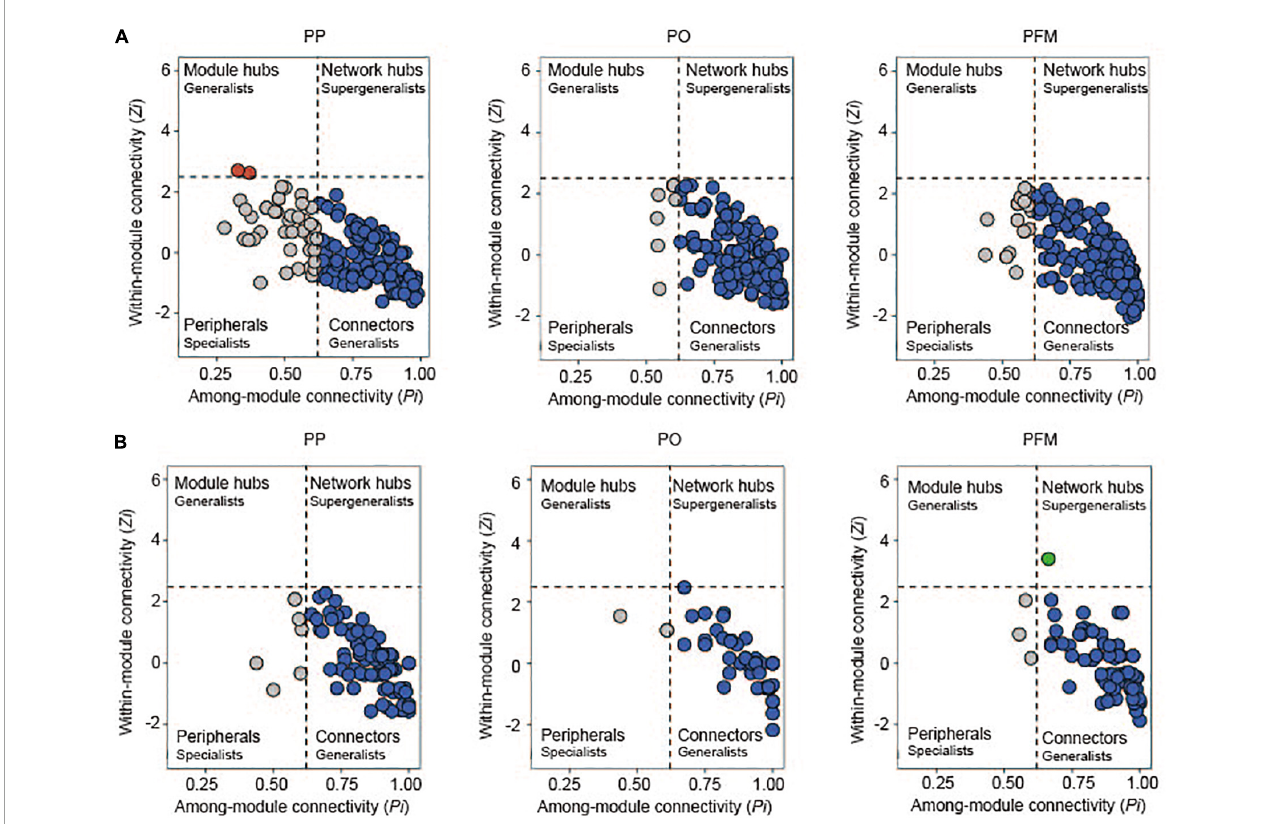
FIGURE5 Zi – Pi plots of bacteria (A) and fungi (B) based on genus topological roles in bacterial and fungal networks. The threshold values of Zi and Pi for categorizing genus were 2.5 and 0.62, respectively. PP, potato continuous cropping; PO, potato–oat rotation; PFM, potato–forage maize rotation.